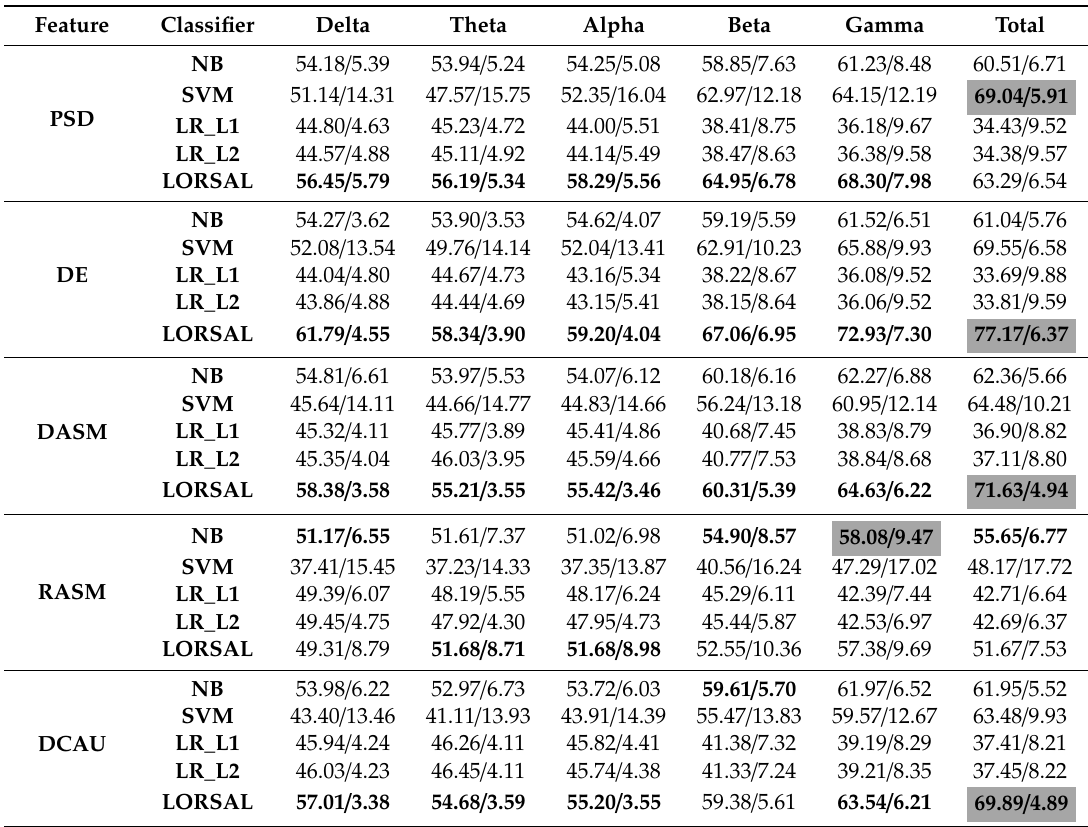
Table 1. The mean precisions and standard deviations (%) of the classification of LV / HV emotions obtained by the compared classifiers for di ff erent features extracted from di ff erent frequency